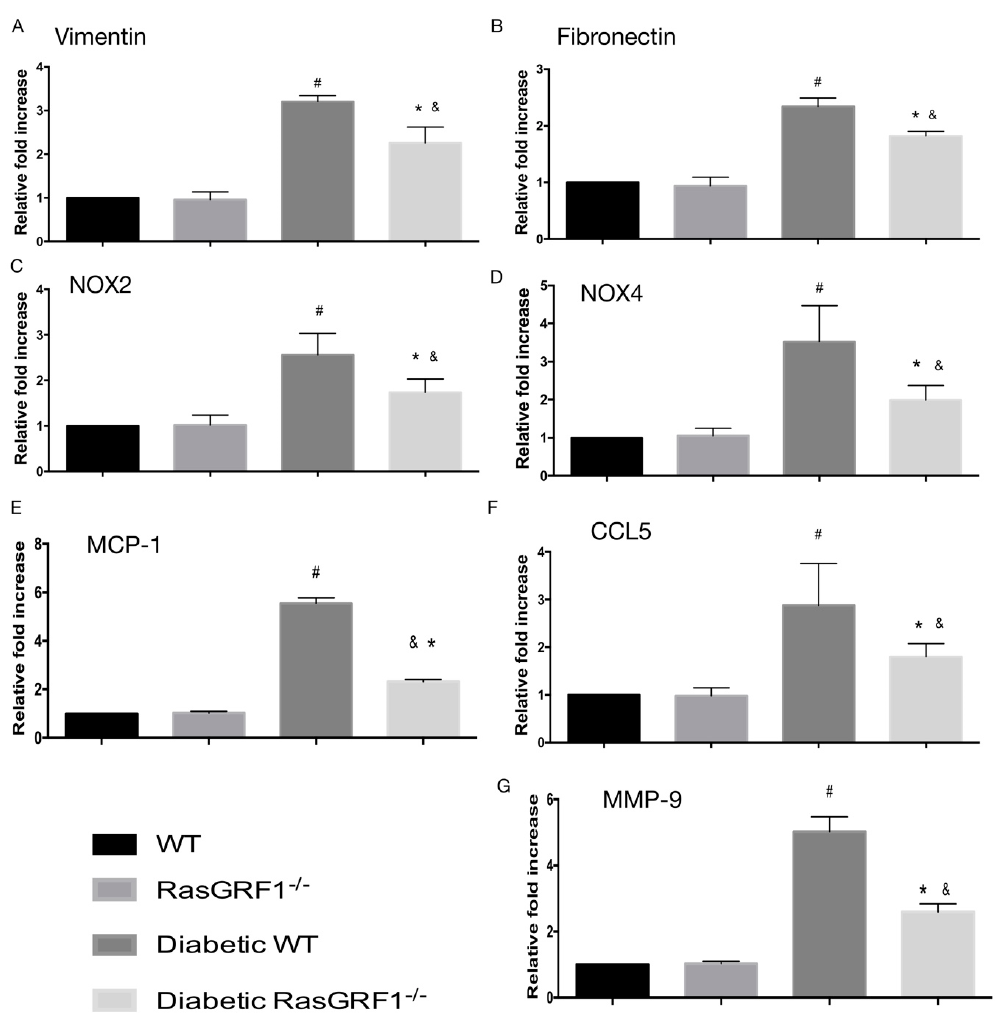
Figure 6. Effects of RasGRF1 knockout on mRNA expression in diabetes-induced extracellular matrix accumulation, inflammation cytokines and oxidative stress. The diabetic condition caused the upregulation of the extracellular matrices of vimentin, fibronectin, oxidative stress, NOX2 and NOX4, and the inflammatory cytokines and chemokines mRNA, MCP-1, chemokine (C–C motif) ligand 5 (CCL5), and matrix metalloproteinase 9 (MMP-9) levels of heart tissue ( n = 5). In additional, the diabetic condition-induced upregulation of the extracellular matrices, oxidative stress, inflammatory cytokines and chemokines, and mRNA can be inhibited by RasGRF1 − / − mice. Data are shown as mean ± SEM from three independent experiments. # p < 0.01 vs. normal WT and normal RasGRF1 − / − mice; * p < 0.05 vs. diabetic WT mice. & p < 0.05 vs. normal WT and normal RasGRF1 − / − mice. WT: wild-type.